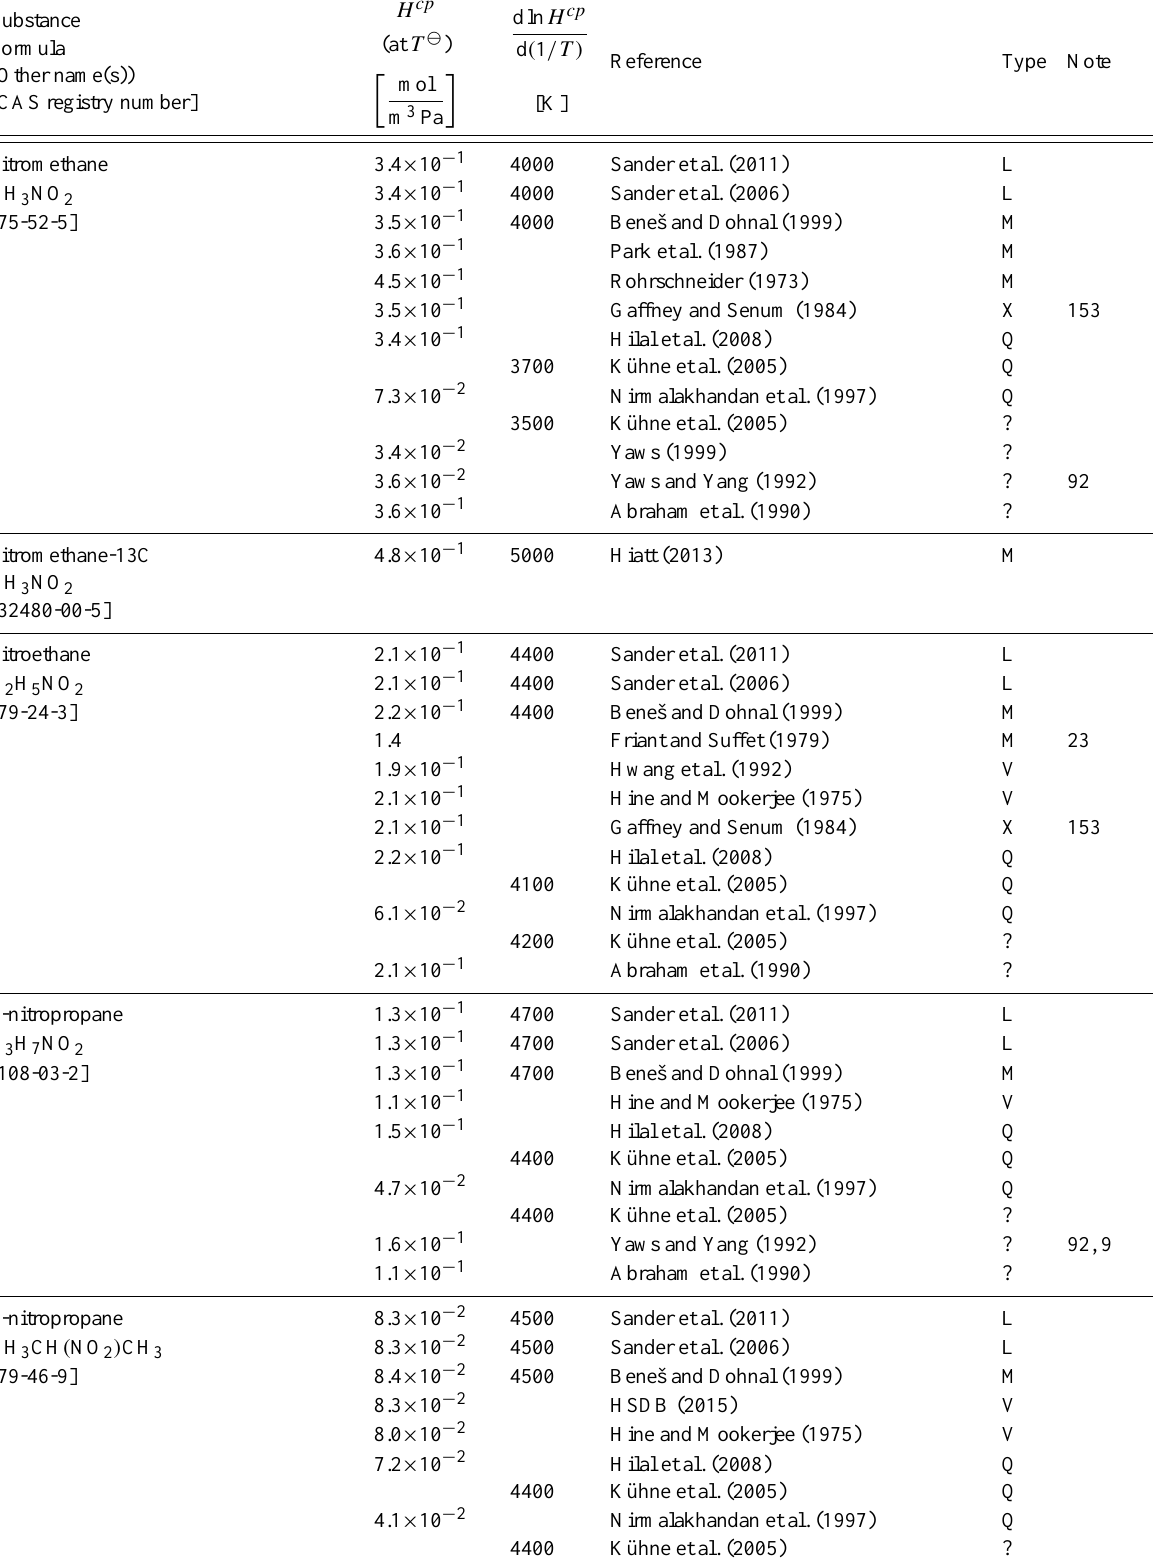
Table 6: Henry’s law constants for water as solvent